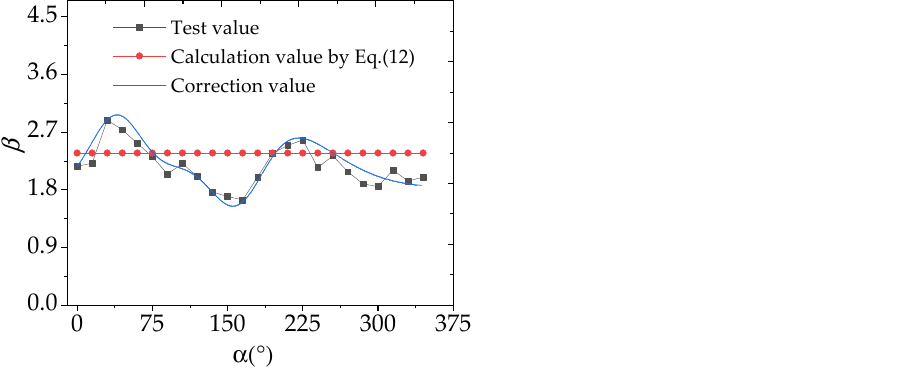
Figure 11. Comparison of displacement wind-induced vibration coefficients determined by American load code, by model wind tunnel test data and by the proposed corrected method using η ( θ ).